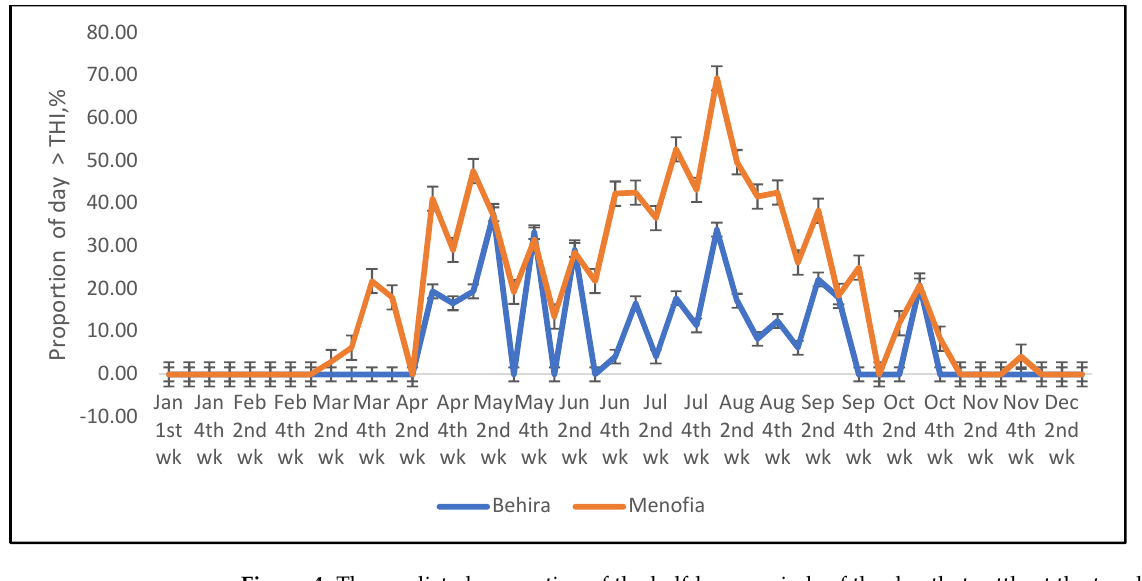
Figure 4. The predicted proportion of the half-hour periods of the day that cattle at the two locations (Behira and Menofia) are likely to experience THI greater than that believed to cause heat stress, after addition of temperature increment expected from climate change [38].